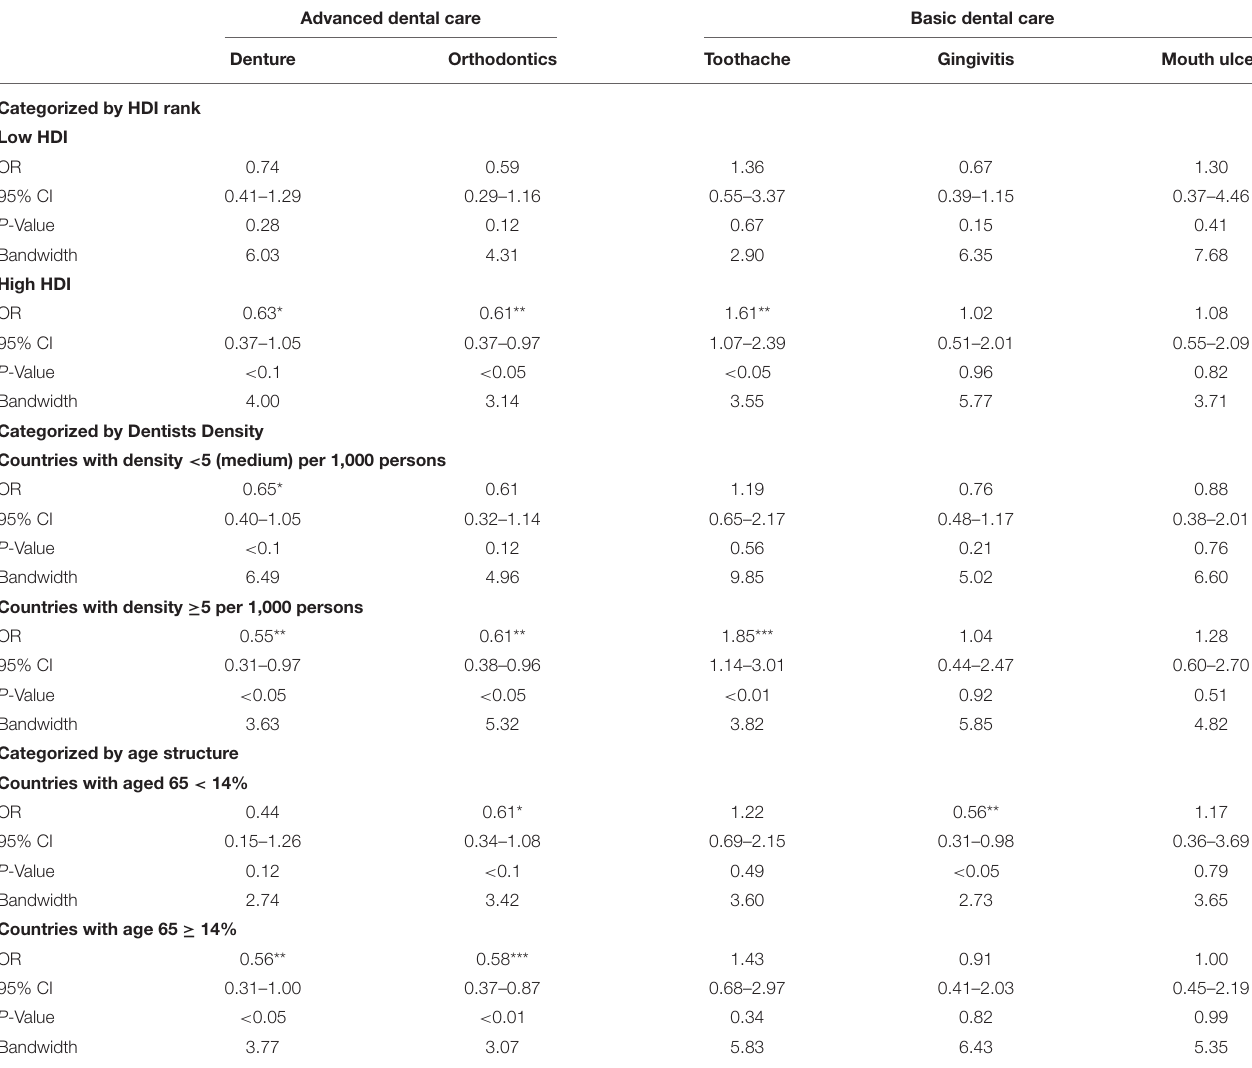
TABLE 6 | Regression continuity estimates of COVID-19 on five dental care keywords in countries with different backgrounds. Advanced dental care Basic dental care